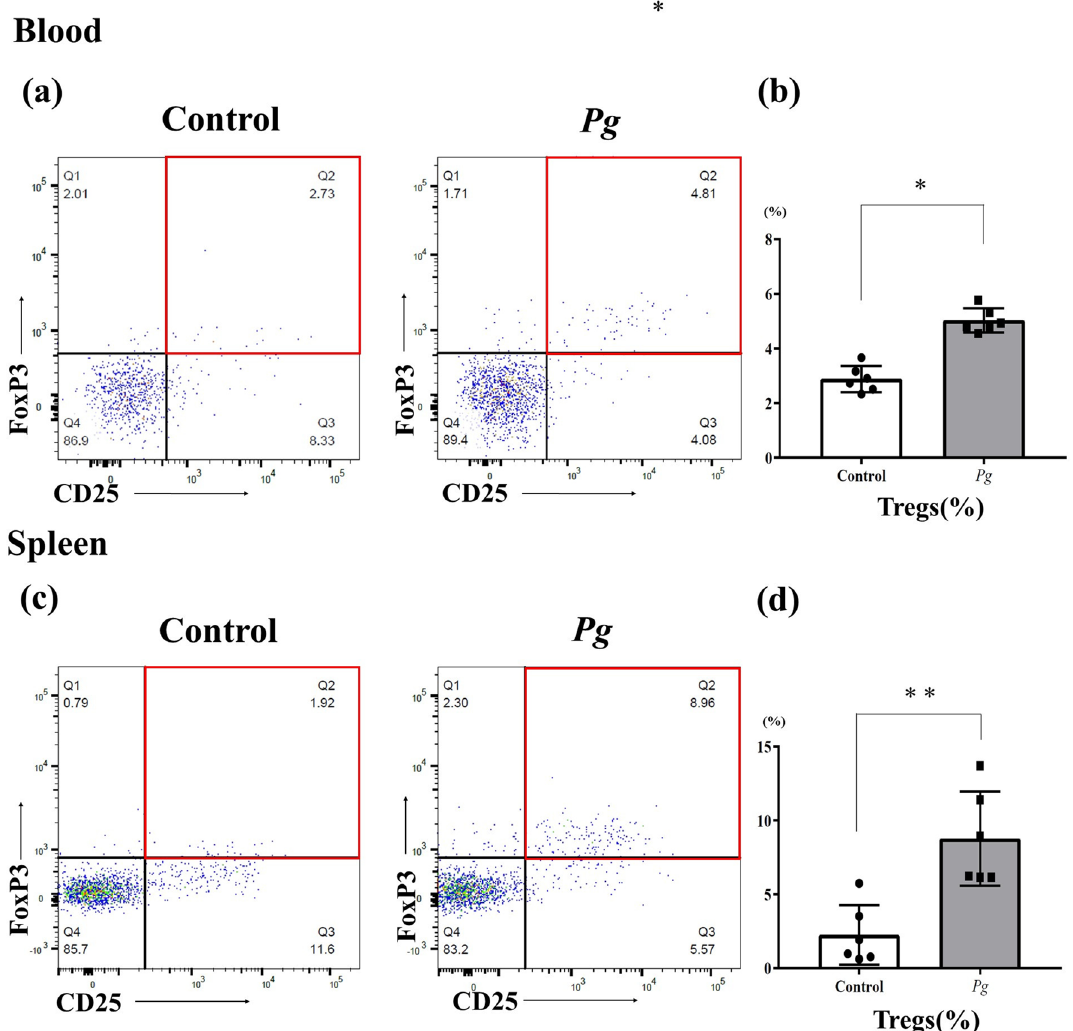
Figure 4. Flow cytometry analysis of cells from both groups. The proportion of Tregs out of CD4+ T cells in the peripheral blood ( a ) and spleen ( c ) in the Pg group and the control group before transplantation, as determined by flow cytometry (each group: n = 6). Statistical analysis was performed to identify differences between the groups. ( b ) Peripheral blood, ( d ) spleen. * p < 0.05, ** p <